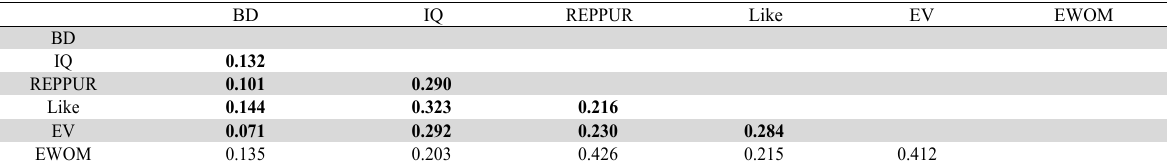
Heterotrait–Monotrait Ratio